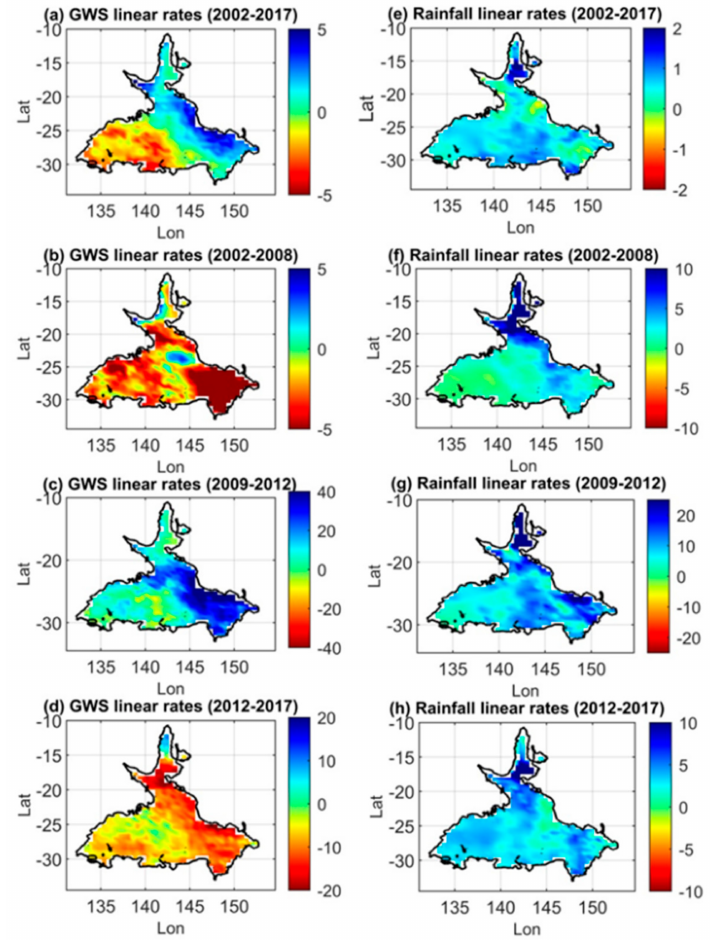
Figure 8. Patterns of GWS linear rates ( a – d ) and rainfall linear rates ( e – h ). All units are in